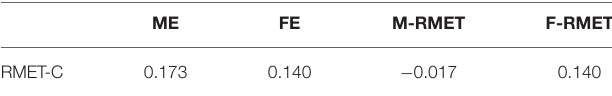
TABLE 1 | Descriptive statistics: Age, Reading the Mind in the Eyes Test, Gender Recognition task, Education, 4 Peabody Picture Vocabulary Test, Raven Progressive Matrices.